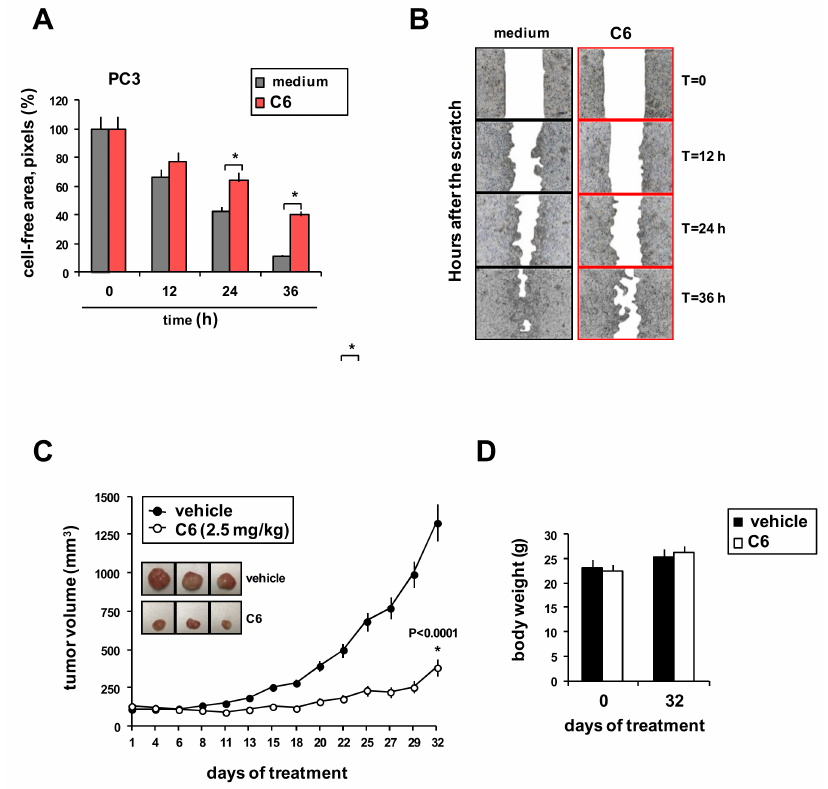
Figure 4. Compound C6 reduces cell migration and PC3 tumor xenograft growth. ( A , B ) Scratch assay. Confluent monolayers of PC3 cells were treated or not with compound C6 (IC 50 ) for 3 h in complete medium, “wounded” by scraping, then cultured in low serum medium and photographed every 12 h for up to 36 h. ( A ) Cell-free area remaining over time as cells migrated into the wound, normalized to time 0. Bar graph shows the mean and SD of three experiments each done in triplicate. * p < 0.05, Student’s t test. ( B ) Representative phase contrast photomicrographs, original magnification 4 × . ( C ) Growth of xenografts in nude mice inoculated with PC3 cells (3 × 10 6 cells/animal) and treated intratumorally with C6 (2.5 mg/kg) ( n = 5) or vehicle ( n = 5). Values are mean and SD. Student’s t test, * p < 0.0001. ( D ) Body weights of xenografted mice ( n = 5 per